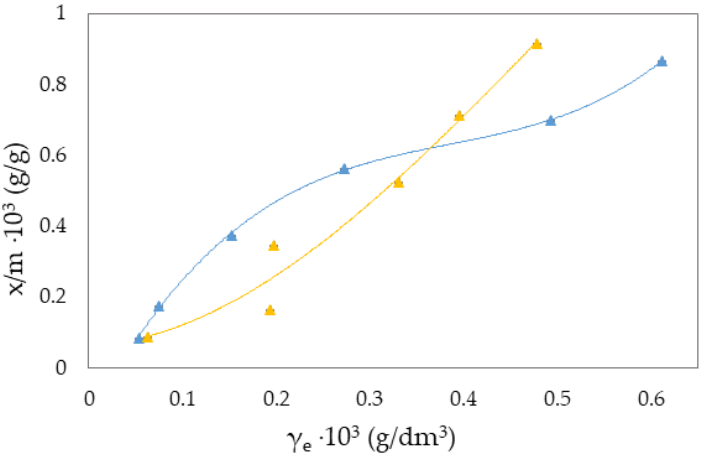
Figure 4. Freundlich adsorption isotherm curves for the suspension MB-NH 4 BETA at ▲ 283 K and (cid:78) 293 K.